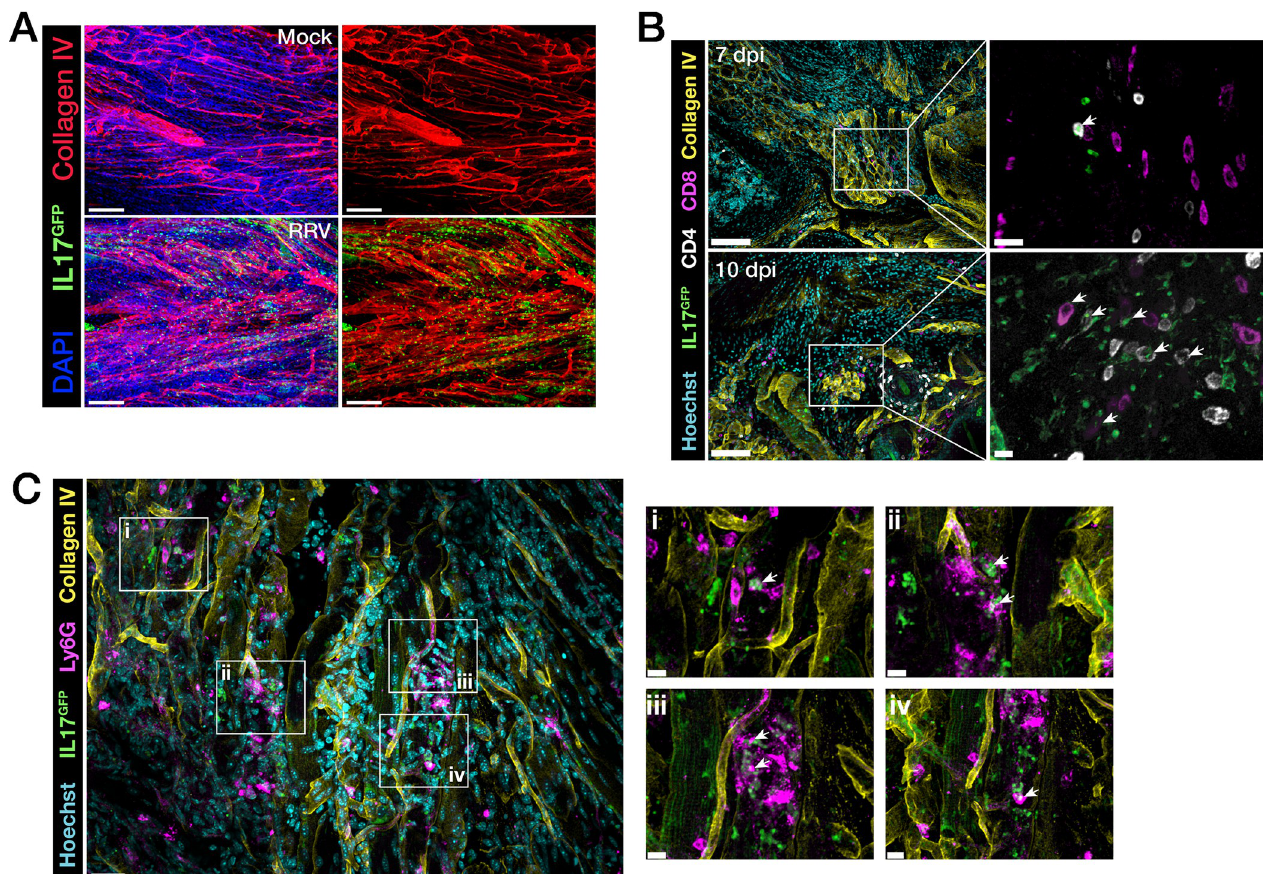
Fig 4. IL-17–expressing cells infiltrate joint tissues during RRV disease. A) Confocal microscopy of immunofluorescent staining of optically cleared 150 μ m − thick vibratome sections of feet from mock-infected or RRV-infected IL-17 GFP mice, at 10 dpi. Scale bars = 50 μ m. Wholemount sections were stained for Type IV Collagen (red) and nuclei labelled with DAPI (blue). B) Immunofluorescent staining of CD4 + , CD8 + T cells and Type IV Collagen in foot cryosections from mock-infected or RRV-infected IL-17 GFP mice at 7 and 10 dpi. Scale bars = 100 μ m (left panels) and 15 μ m (right panels). C) Immunofluorescent staining of Ly6G + neutrophils and Type IV Collagen in foot cryosections RRV-infected IL-17 GFP mice, at 10 dpi. Arrows indicate GFP +ve cells. Nuclei were labelled with Hoechst 33258. Scale bars = 30 μ m (left panel) and 10 μ m (insets). Images acquired as z-stacks and shown as maximum intensity projections. Data representative of 3 independent experiments (n = 5 mice per group).